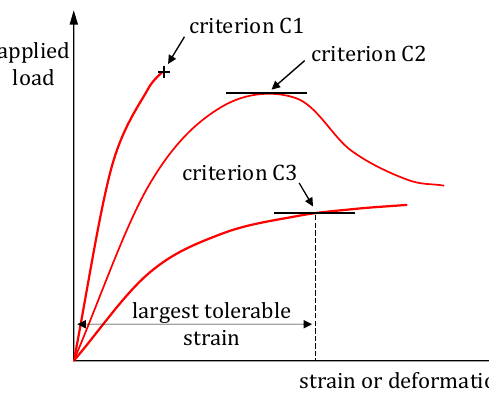
Figure 3. Determination of structural resistance by materially non-linear analysis [1].